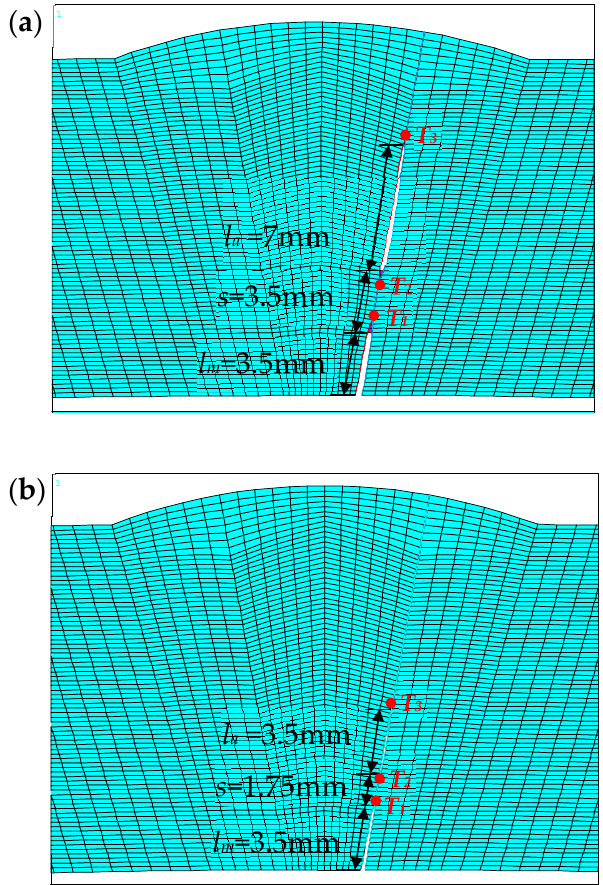
(cid:2869) , , ( b ) 𝛾 (cid:3039) = 1 ， 2 (cid:2870)